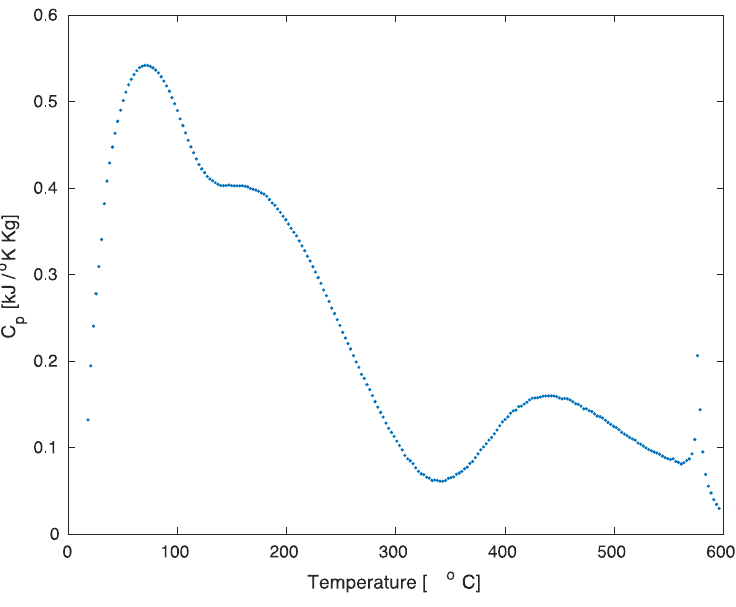
Figure 11. Apparent specific heat capacity.